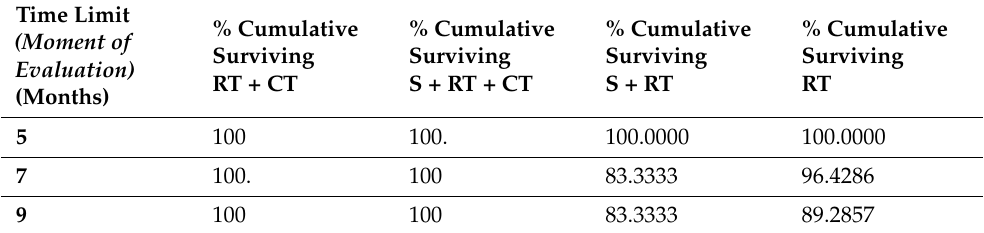
Table 4. Life-table to evaluate the survival rate of carcinomas of the oral mucosa vs. treatment type. Time